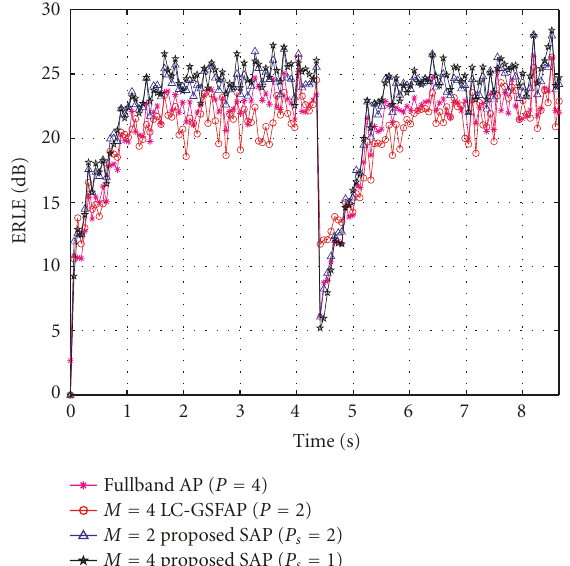
Figure 8: ERLE curves of the fullband AP with P = 4, M = 4 LC- GSFAP with P = 2, OS = 2, and D = 2, M = 2 SAP with P s = 2, and M = 4 SAP with P s = 1 for AR(4) inputs ( N = 512, μ = 1, SNR = 30dB).